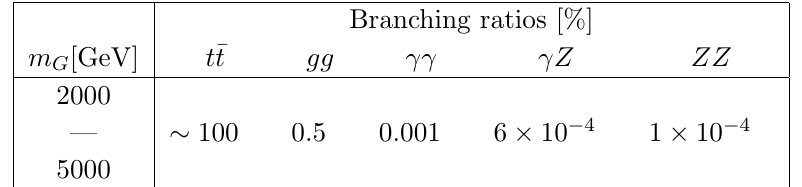
Table 1 . Branching ratios of the KK graviton for c tt = c 1 = c gg = 1.